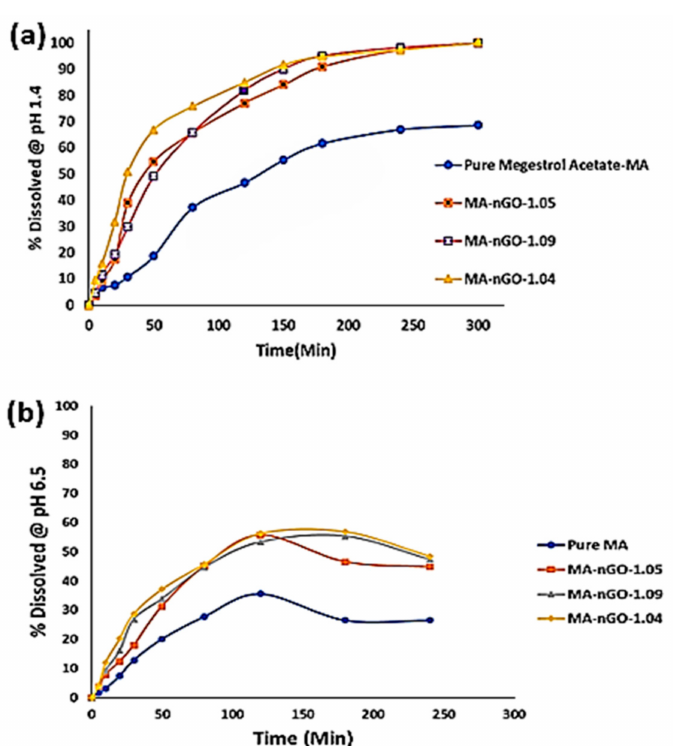
Figure 10. Dissolution profile for MA-nGO-drug composites ( a ) at pH 1.4 and ( b ) at pH